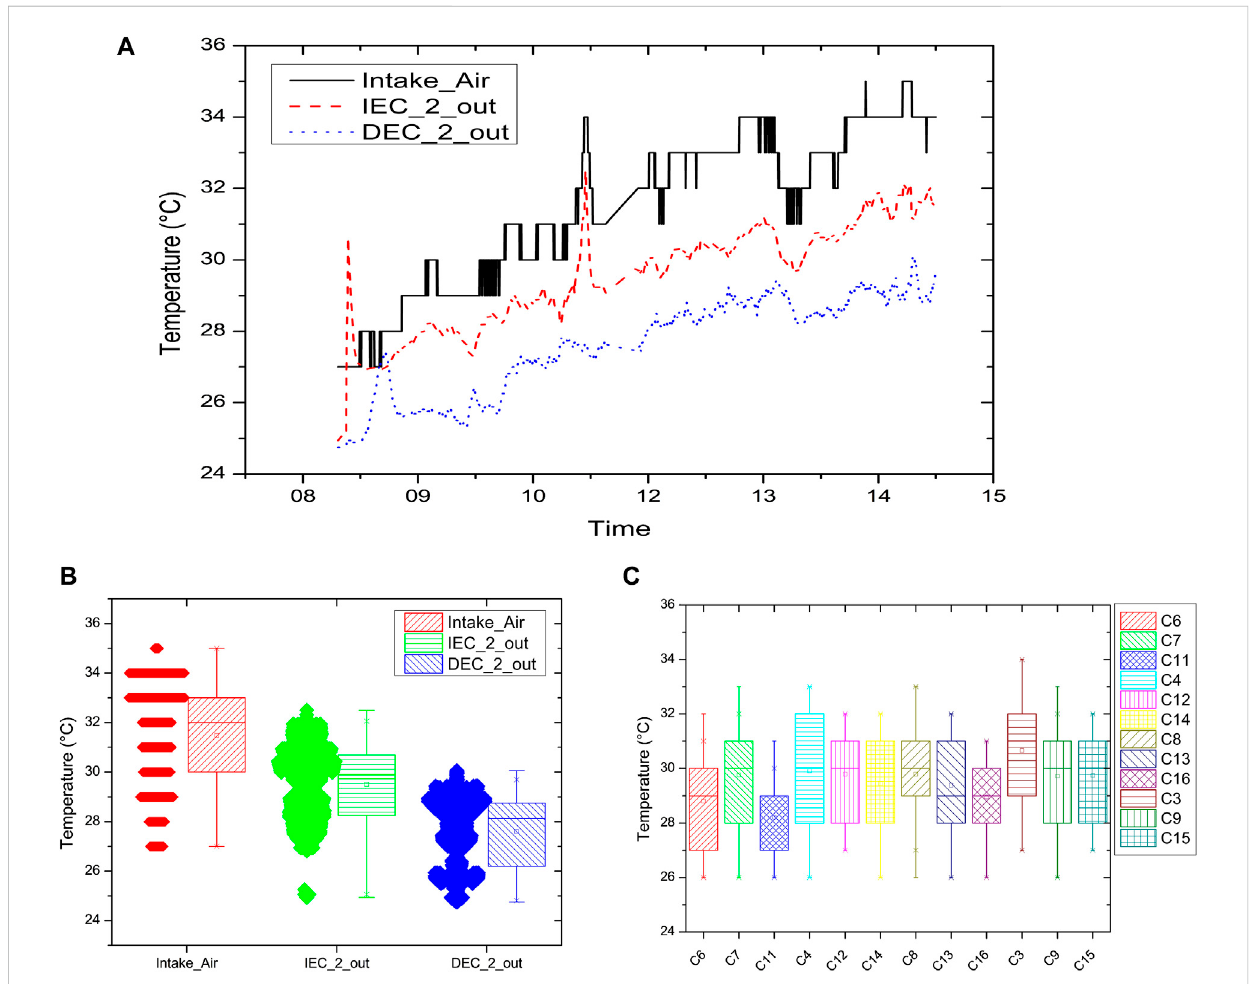
FIGURE 4 Real time temperature data on the proposed WIEC passive system from (A) the measurement from 0845 until 1451, (B) the corresponding mean value of temperature showing a general decreasing trend, and (C) scattering of temperature values recorded in the testing chamber.